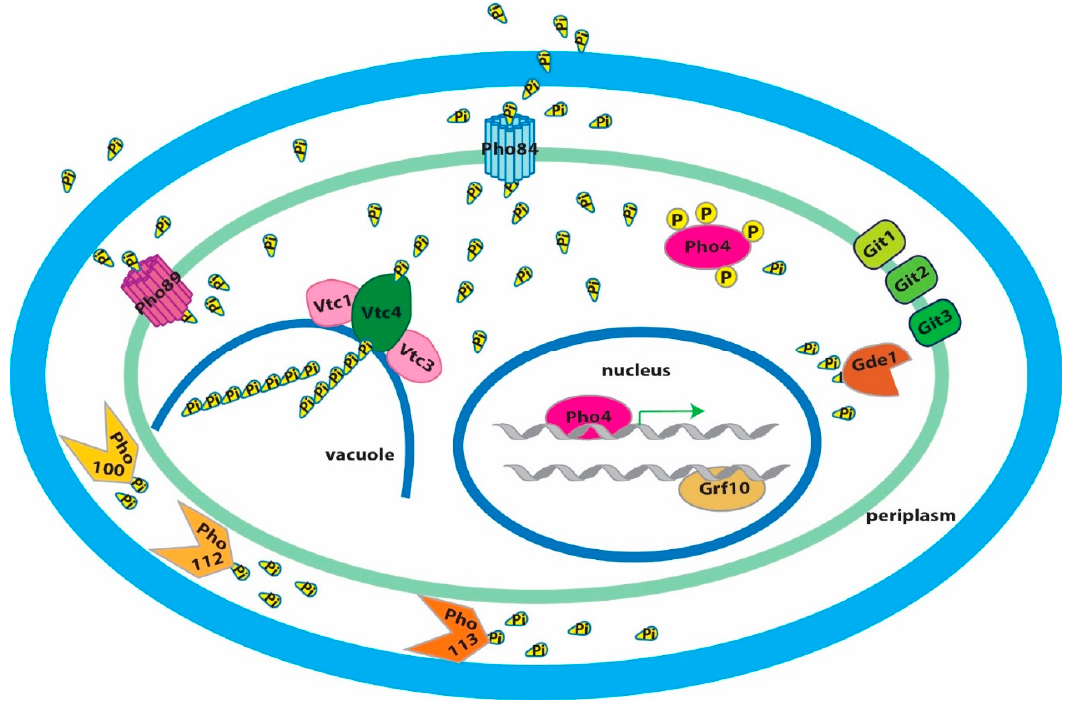
Figure 1. Model: Candida albicans phosphate (Pi) homeostasis maintenance . Under limited Pi conditions, Pi is imported by high-affinity transporters Pho84 and Pho89 whose pH optimum is in the acidic and alkaline range, respectively. Decreased Pi availability also activates the PHO regulon, whose central transcription factor Pho4 is dephosphorylated and localized to the nucleus. Independent of the interaction with the Pho2 homolog Grf10, Pho4 alone activates the expression of genes to maintain intracellular Pi homeostasis, including high-affinity Pi transporters ( PHO84 and PHO89 ), polyphosphate synthesis complex ( VTC1–4 ), glycerophosphodiester transporters ( GIT1–3 ), glycerophosphocholine phosphodiesterase ( GDE1 ), as well as acid phosphatases ( PHO100 , 112, and 113 ).